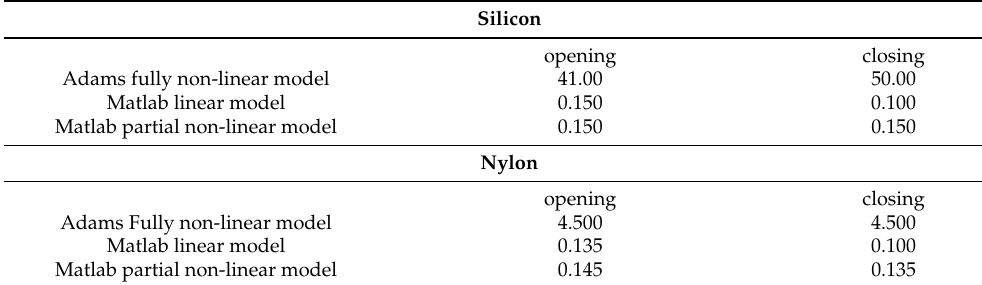
Table 8. CPU-time comparison in seconds for the opening–closing